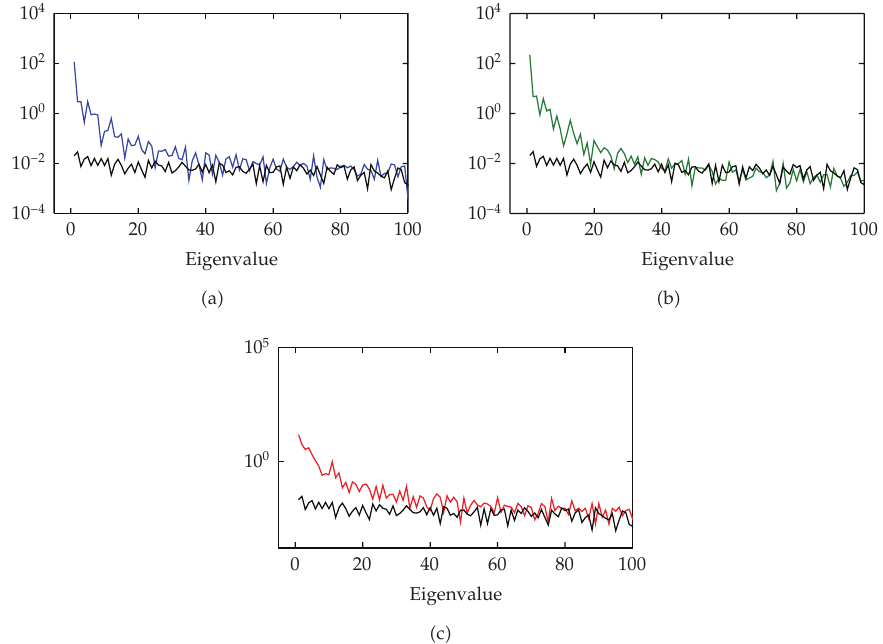
Figure 5: Comparison of the ω spectra for the raw (cid:3)(cid:3) a (cid:4) , blue (cid:4) , a ffi nity (cid:3)(cid:3) b (cid:4) , green (cid:4) , and partial (cid:3)(cid:3) c (cid:4) , red (cid:4) correlations, to the corresponding random matrix case (cid:3) black (cid:4) . Data used is of the S&P data, using a semilog plot. Only the first 100 values of ω are